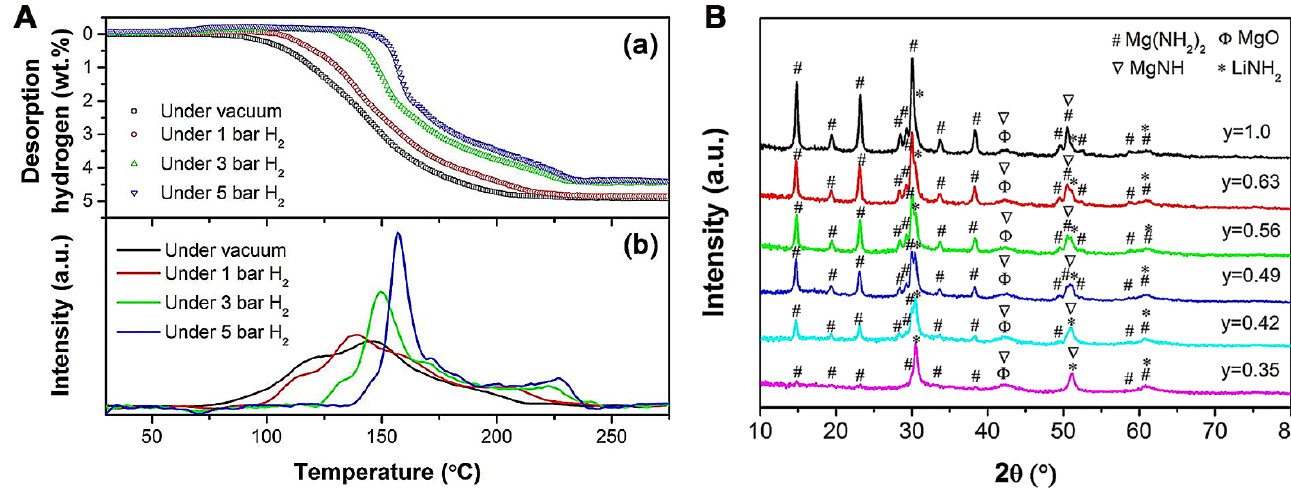
Figure 14. ( A ) Dehydrogenation capacity ( a ) and dehydrogenation velocity ( b ) curves with the temperatures of Mg(NH 2 ) 2 -2LiH-0.07KOH under initial vacuum, 1, 3 and 5 bar hydrogen. ( B ) XRD patterns of the yMg(NH 2 ) 2 -0.35LiH-0.07KOH samples dehydrogenated to 150 ◦ C under argon carrier gas. Figure is reprinted with permission from ref. [168].